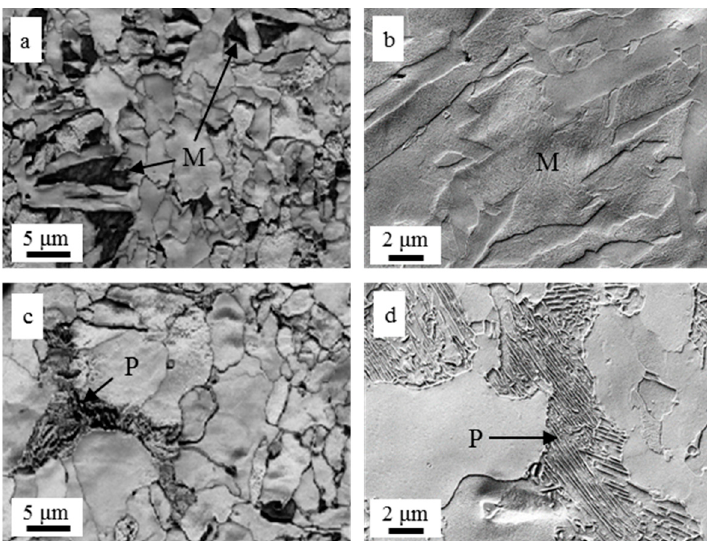
Figure 16. Microstructure investigation of Nb1Mo2 after coiling simulation at 600 °C ( a , b ) and at 650 °C ( c , d ): ( a , c ) are IQ EBSD maps corresponding to the selected area in Figure 15; ( b , d ) are SEM images to identify the structures with low IQ values, i.e., martensite (M) and pearlite (P), respectively.